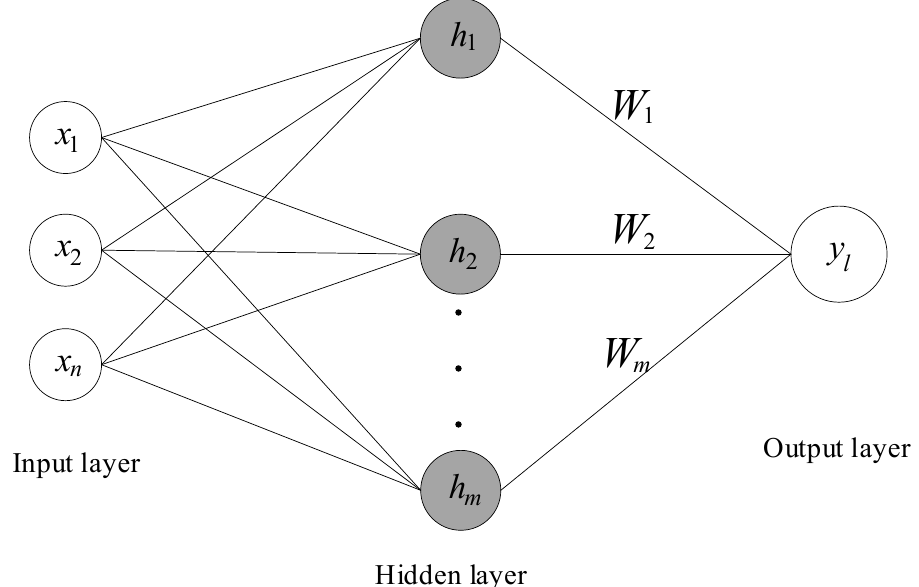
Figure 4. Structure of RBF neural network. The Gaussian function with arbitrary derivative and radial symmetry as radial basis function does not increase the complexity of the analysis when the input is multivariate, which makes it successfully applied in many neural network control situations. Therefore, the Gaussian base function shown below is chosen as the basis function of the